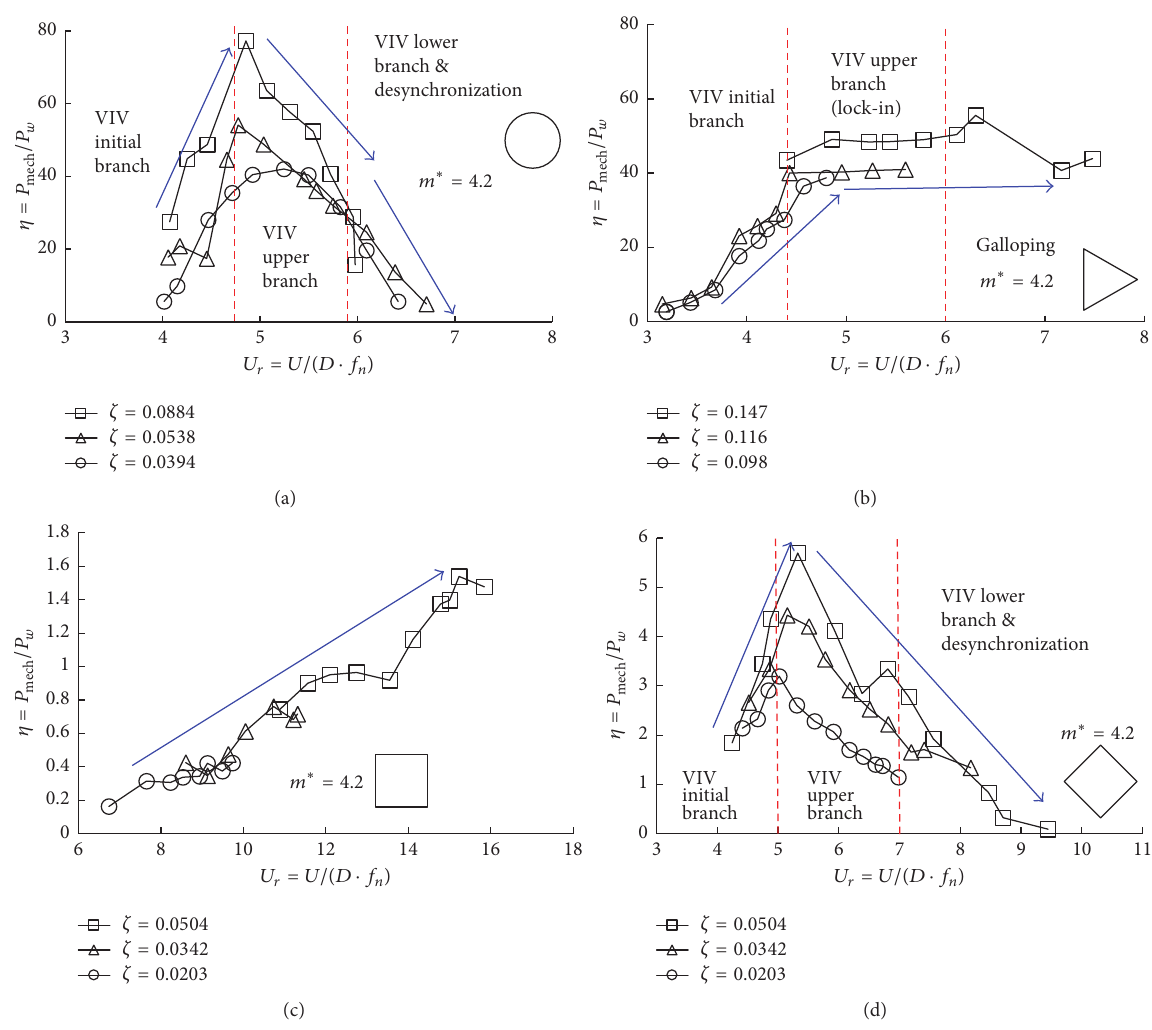
Figure 11: Variations of the energy transfer ratios with the reduced velocities for cylinders or prisms with different cross sections. 𝑚 ∗ = 4.2 . (a) Circular cylinders; (b) regular triangle prisms; (c) right square prisms; (d) diamond prisms. Table 3: The complete results in free decay